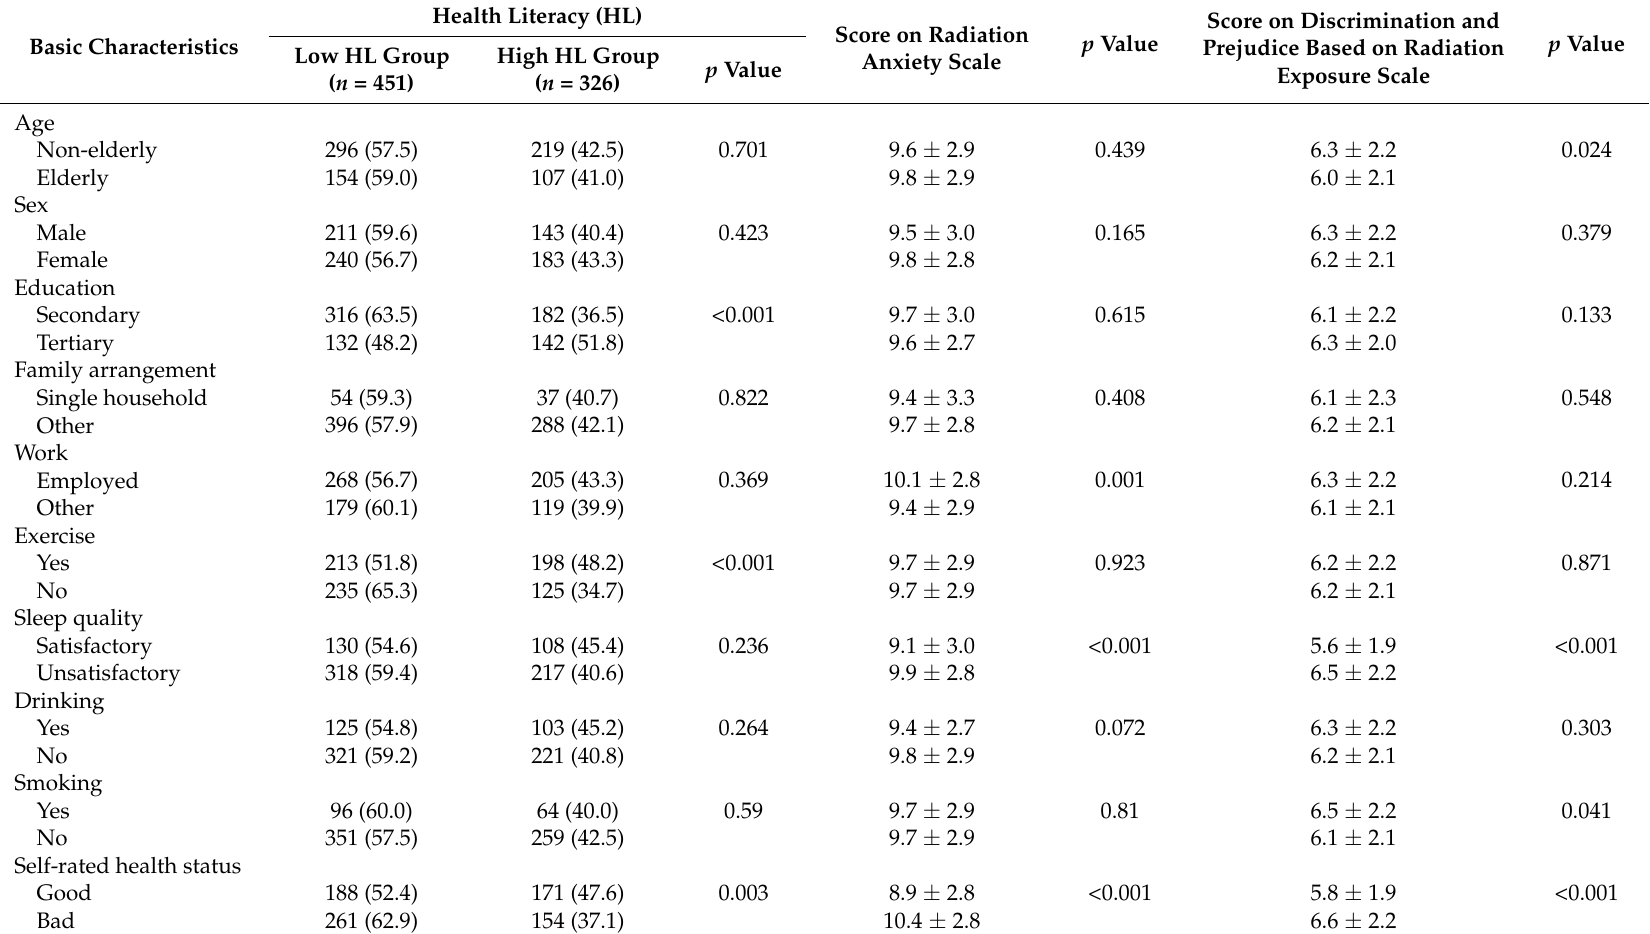
Table 3. Relationship between basic characteristics, health literacy, and radiation